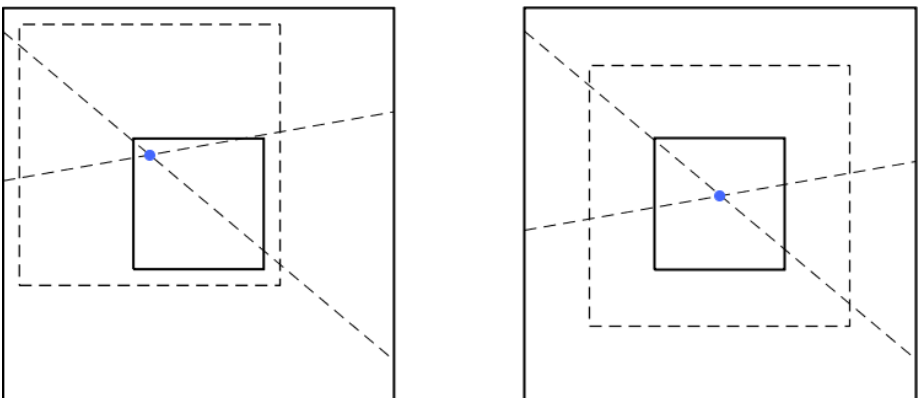
Figure 2. Depiction of extension of backprojected lines to a domain three times larger than input image size. See text for